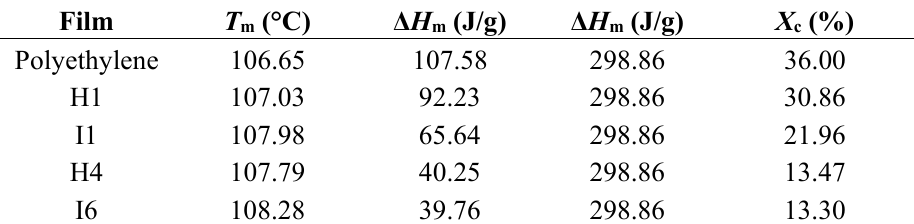
Figure 5. TGA curves for the polymeric materials and their blends. Table 2. Thermal properties of PE and PE blends with